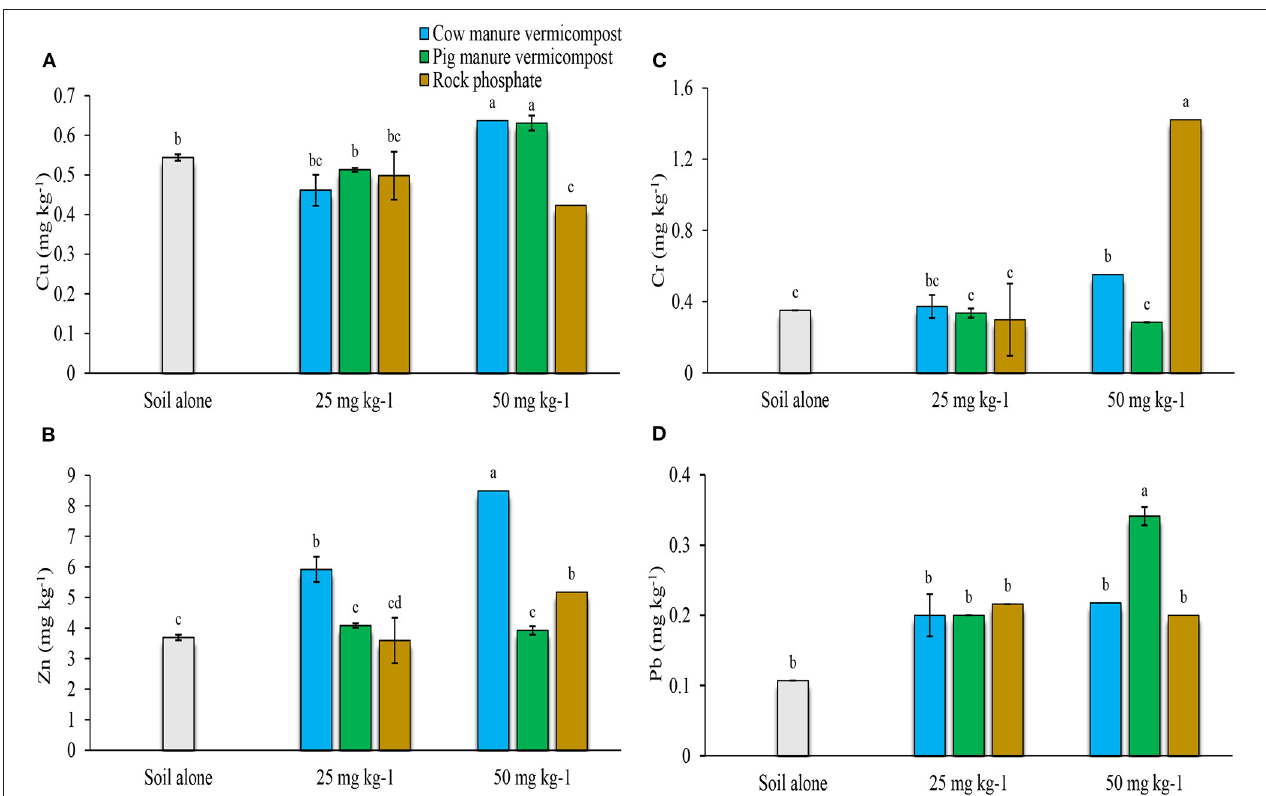
FIGURE 3 | The Cu (A) , Zn (B) , Cr (C) , and Pb (D) content of Swiss chard tissue at week 8 after transplanting using Oxisol soil that has been incorporated with P as RP-enriched cow and pig manure vermicompost and RP at a different level. Error bars represent standard deviations, and significantly different numbers for the same parameter are followed by different letters based on LSD ( p ≤ 0.05). Maximum permissible level of Cu = 5.0mg kg − 1 ( FAO/WHO, 2014), Zn = 1.0mg kg − 1 ( FAO/WHO, 2011), Cr = 2.3mg kg − 1 (FAO/WHO, 1989), and Pb = 0.20 and 20mg kg − 1 (Morgan,